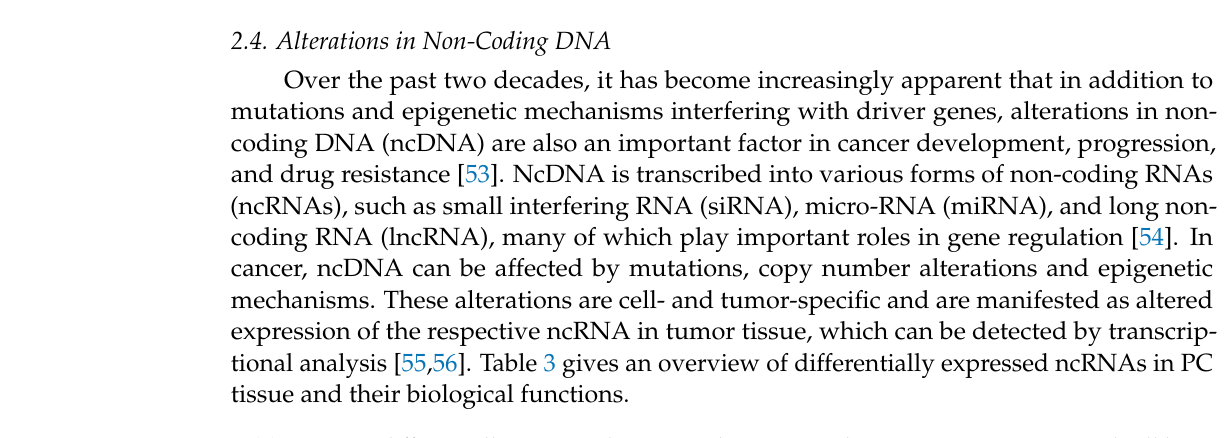
Table 3. Major differentially expressed miRNAs, lncRNAs and circRNAs in PC tissue and cell lines, their targets and biological functions. Compiled and modified from [55,57–59] and references therein, with additions from